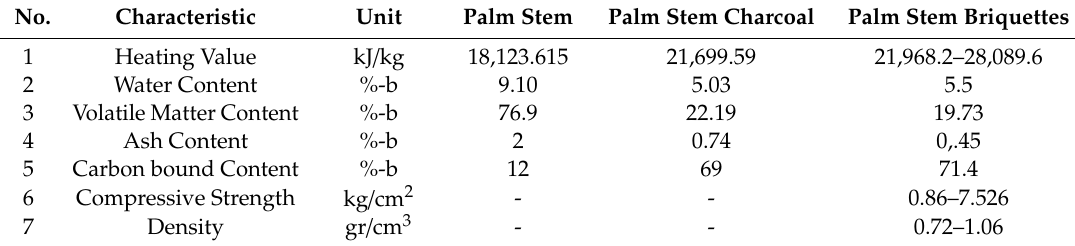
Table 2. Characteristics of Palm Stem, Palm Bar Charcoal, and Palm Stem Briquettes.